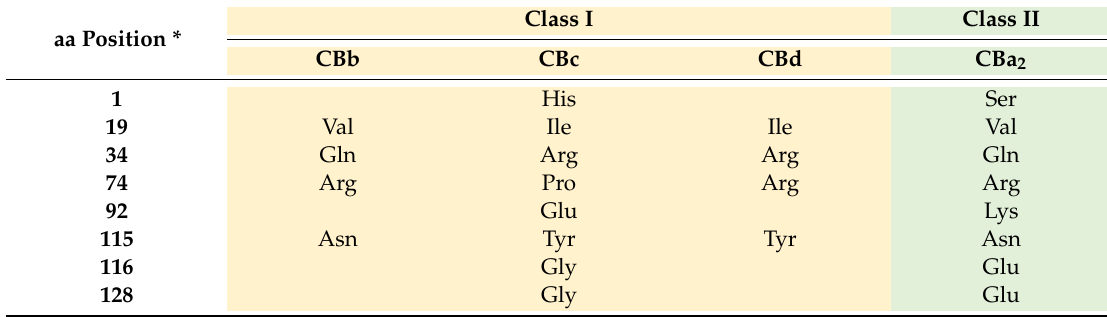
Table 2. Distinguishing residues in CB isoforms form two classes of crotoxin